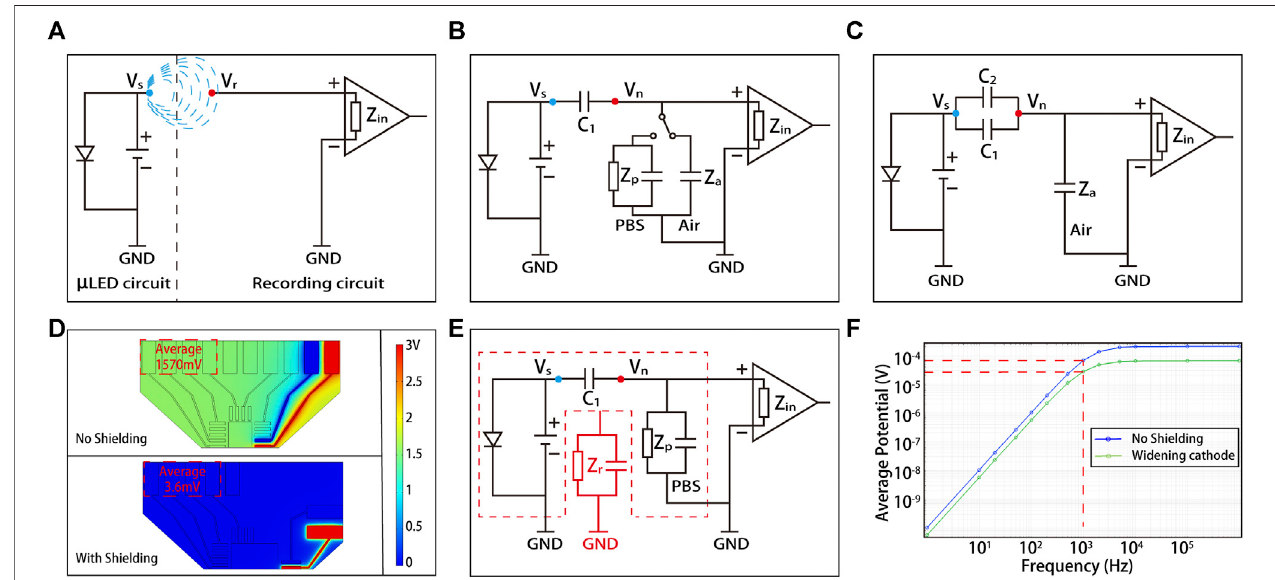
FIGURE6|(A) Thecircuitmodelcorrespondingtothequalitativesimulationenvironment. (B) Thecircuitmodelcorrespondingtotheidealtestenvironmentinairor PBS. (C) The circuit model corresponding to the actual test environment in air. (D) The simulation result of the new PCB ’ s shielding effect. (E) The circuit model corresponding to a quantitative simulation model used to analyze the electric fi eld interference in optrode. (F) The comparison between no-shielding and widening- cathode using the quantitative simulation model for analysis.